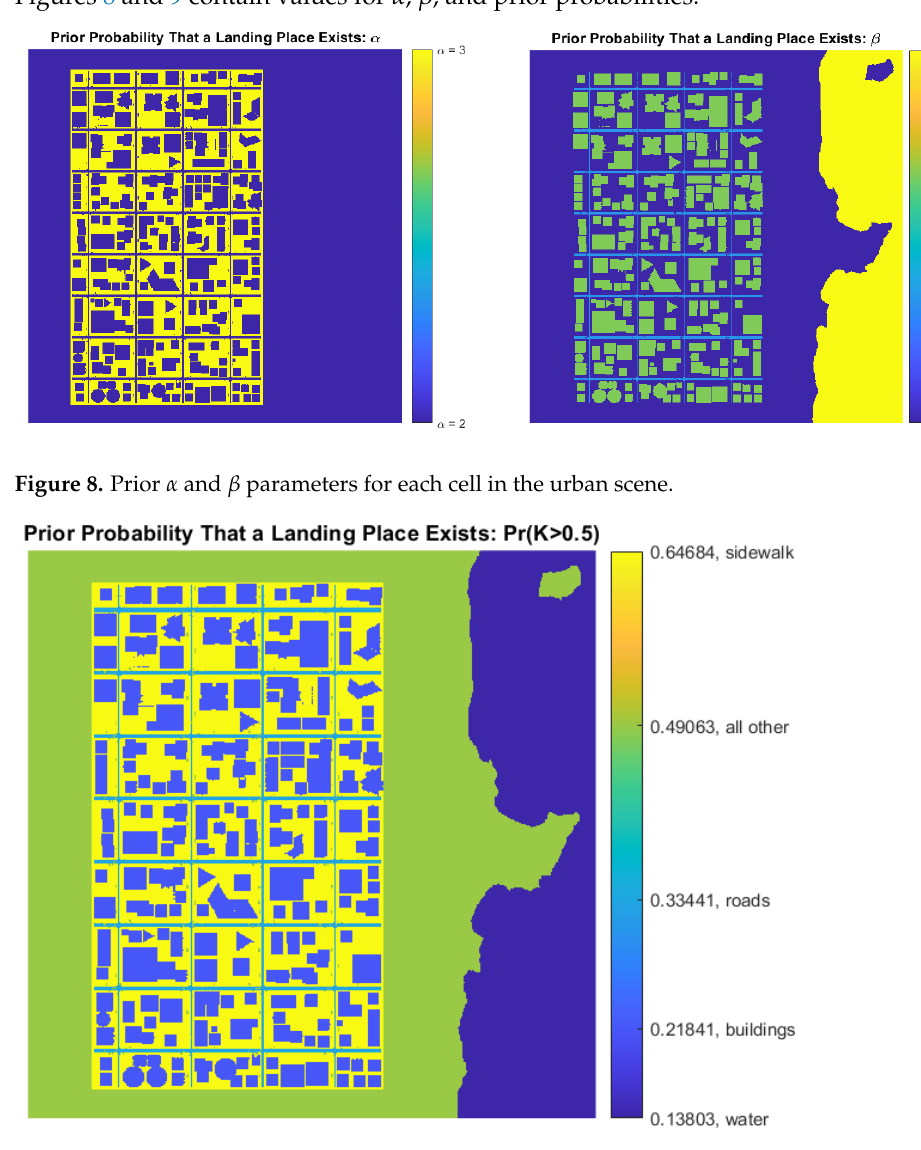
Figure 9. Prior landing probability for κ =